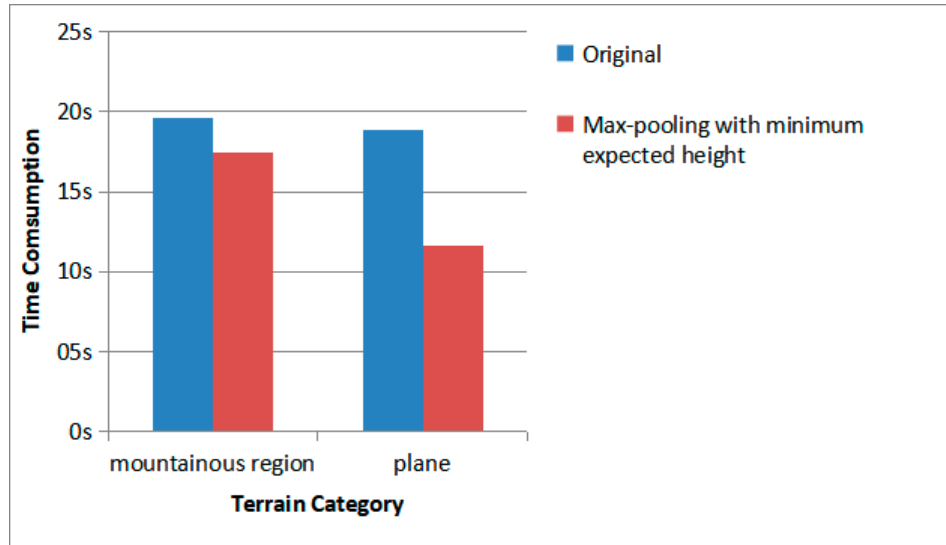
Figure 19. The effect of the maximum pooling-minimum expected height method. The acceleration Figure 19. The e ff ect of the maximum pooling-minimum expected height method. The acceleration effect of plane area was more obvious. e ff ect of plane area was more